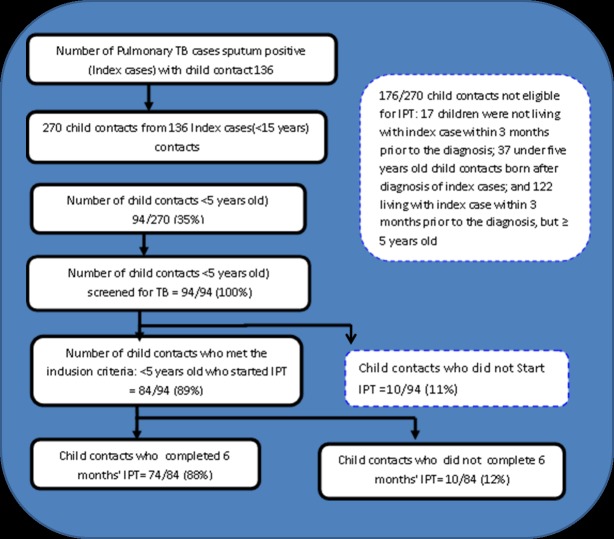
Flow diagram of child contacts from recruitment to IPT completion.